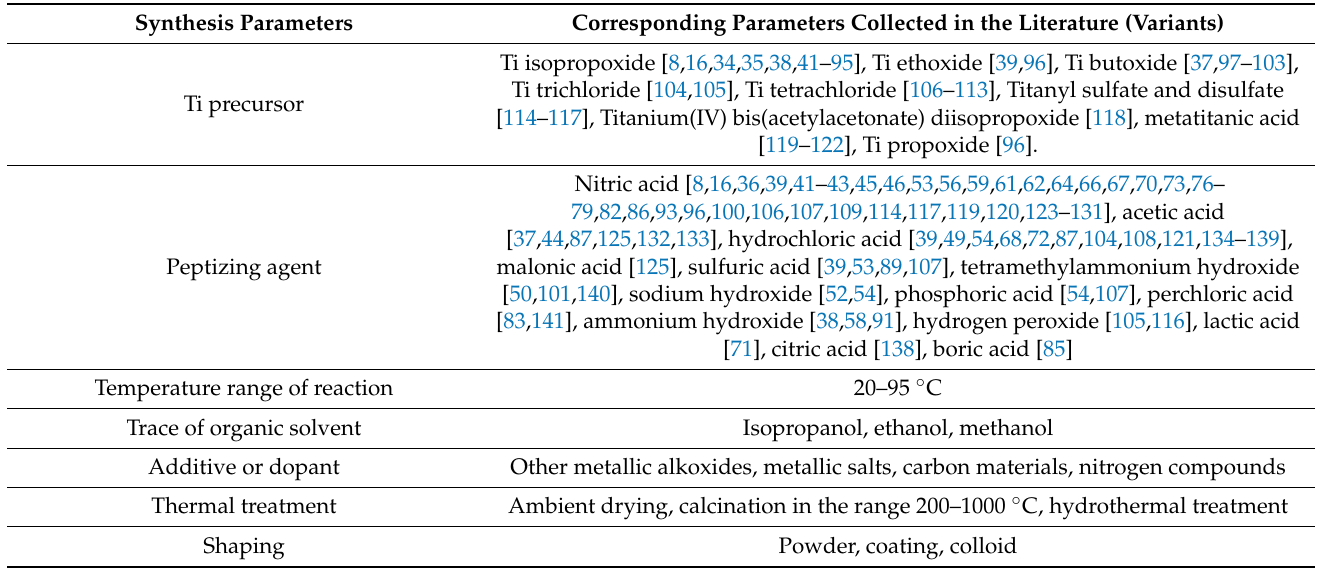
Table 1. Main TiO 2 synthesis